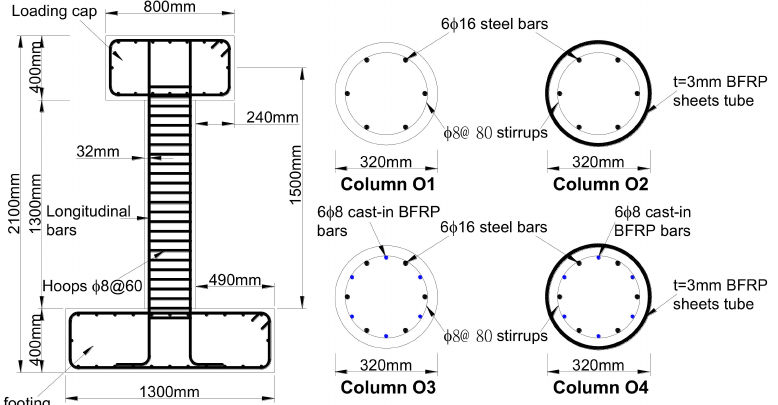
Figure 5. Geometry and reinforcement details of original